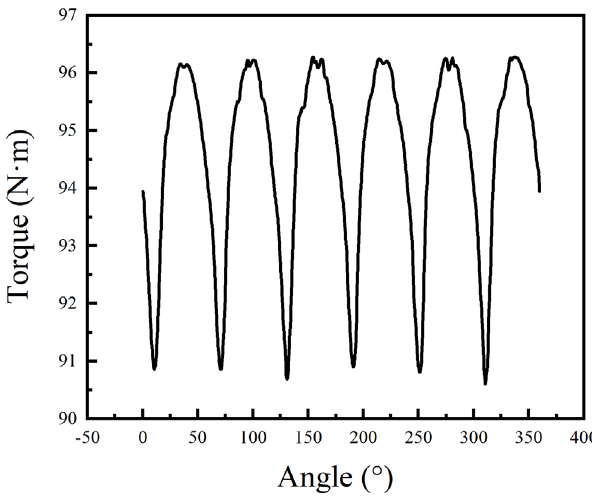
Fig. 15. Calculation result of pump outlet fl ow.